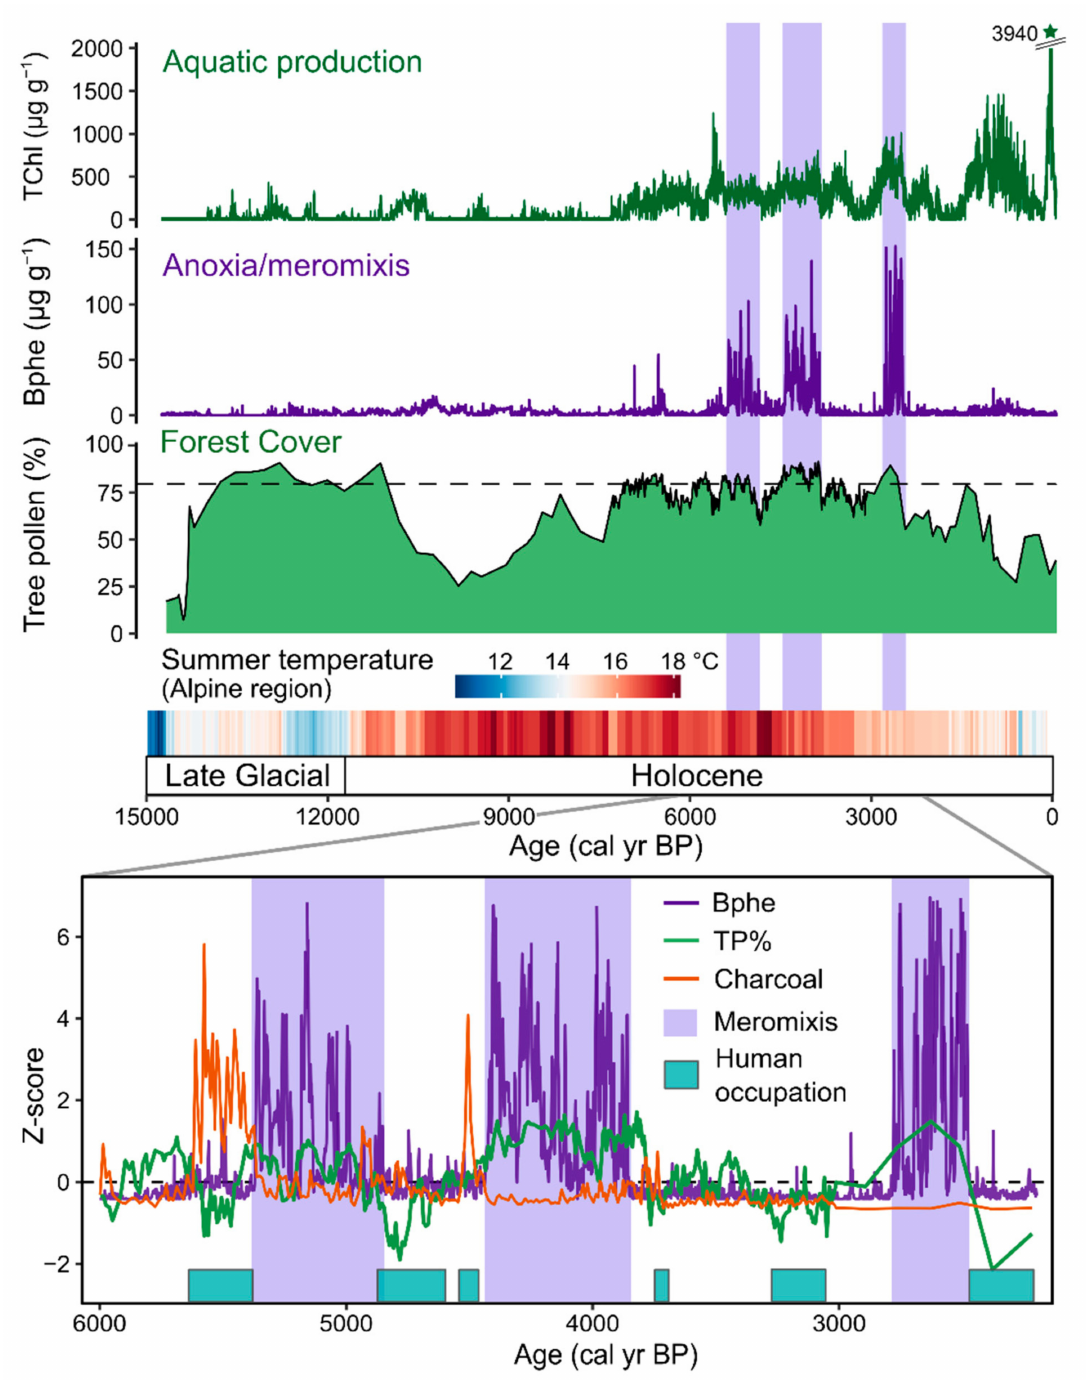
Figure 5. Holocene and Late Glacial (past 15,000 yrs) reconstruction of aquatic productivity and lake mixing from Moossee, Switzerland based on HSI-inferred pigments. Meromixis was inferred from the presence of bacteriopheophytin a based on HSI. Meromictic periods (highlighted in purple shading) occurred during periods of closed forest cover (dashed line in the forest cover plot indicates closed forests with 80% tree pollen) and warm summer temperatures. Human-caused forest openings led to periods of greater lake mixing. Modified from Makri et al. [43]. Summer temperature reconstruction inferred for the Alpine region based on chironomids